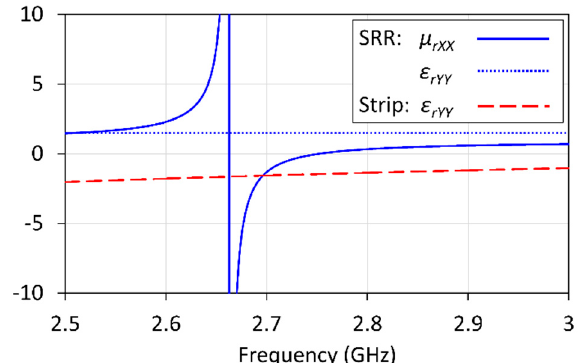
Figure 5. Theoretical predictions of anisotropic permittivity and permeability for the SRR and strip loaded waveguides of the type considered in this work. (In color.).